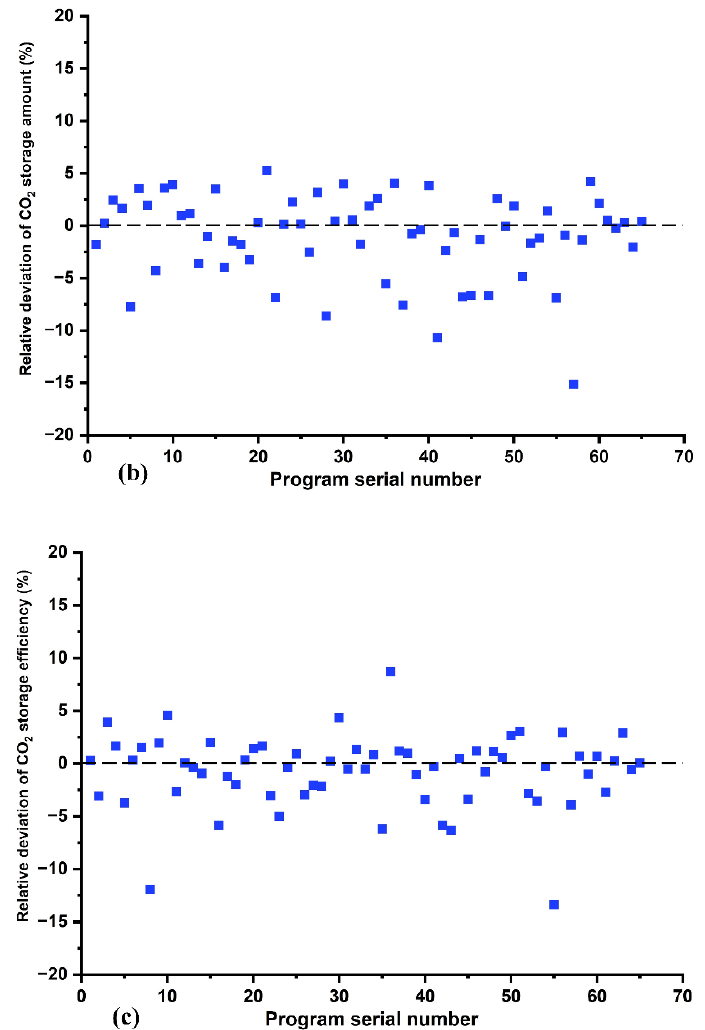
Figure 13. Relative deviation between the predicted value and true value in ( a ) cumulative oil pro- production, ( b ) CO 2 storage amount, and ( c ) CO 2 storage duction, ( b ) CO 2 storage amount, and ( c ) CO 2 storage efficiency.